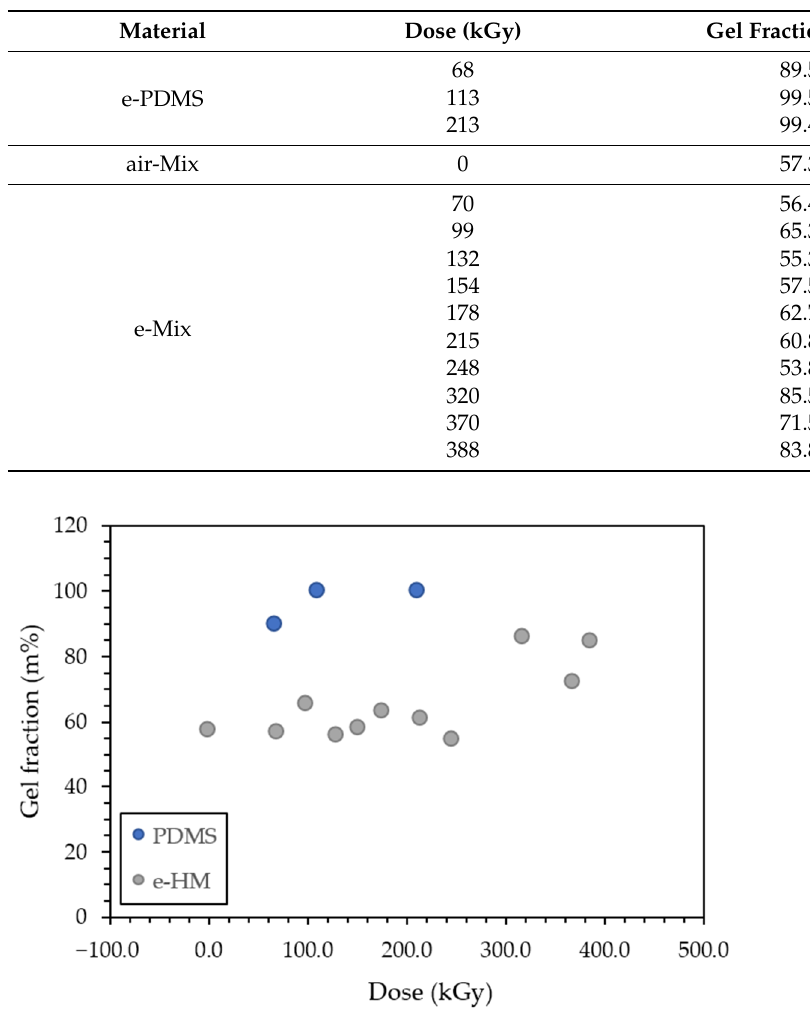
Figure 2. PDMS and e-Mix determined gel fraction (m%) as a function of absorbed Dose (kGy).